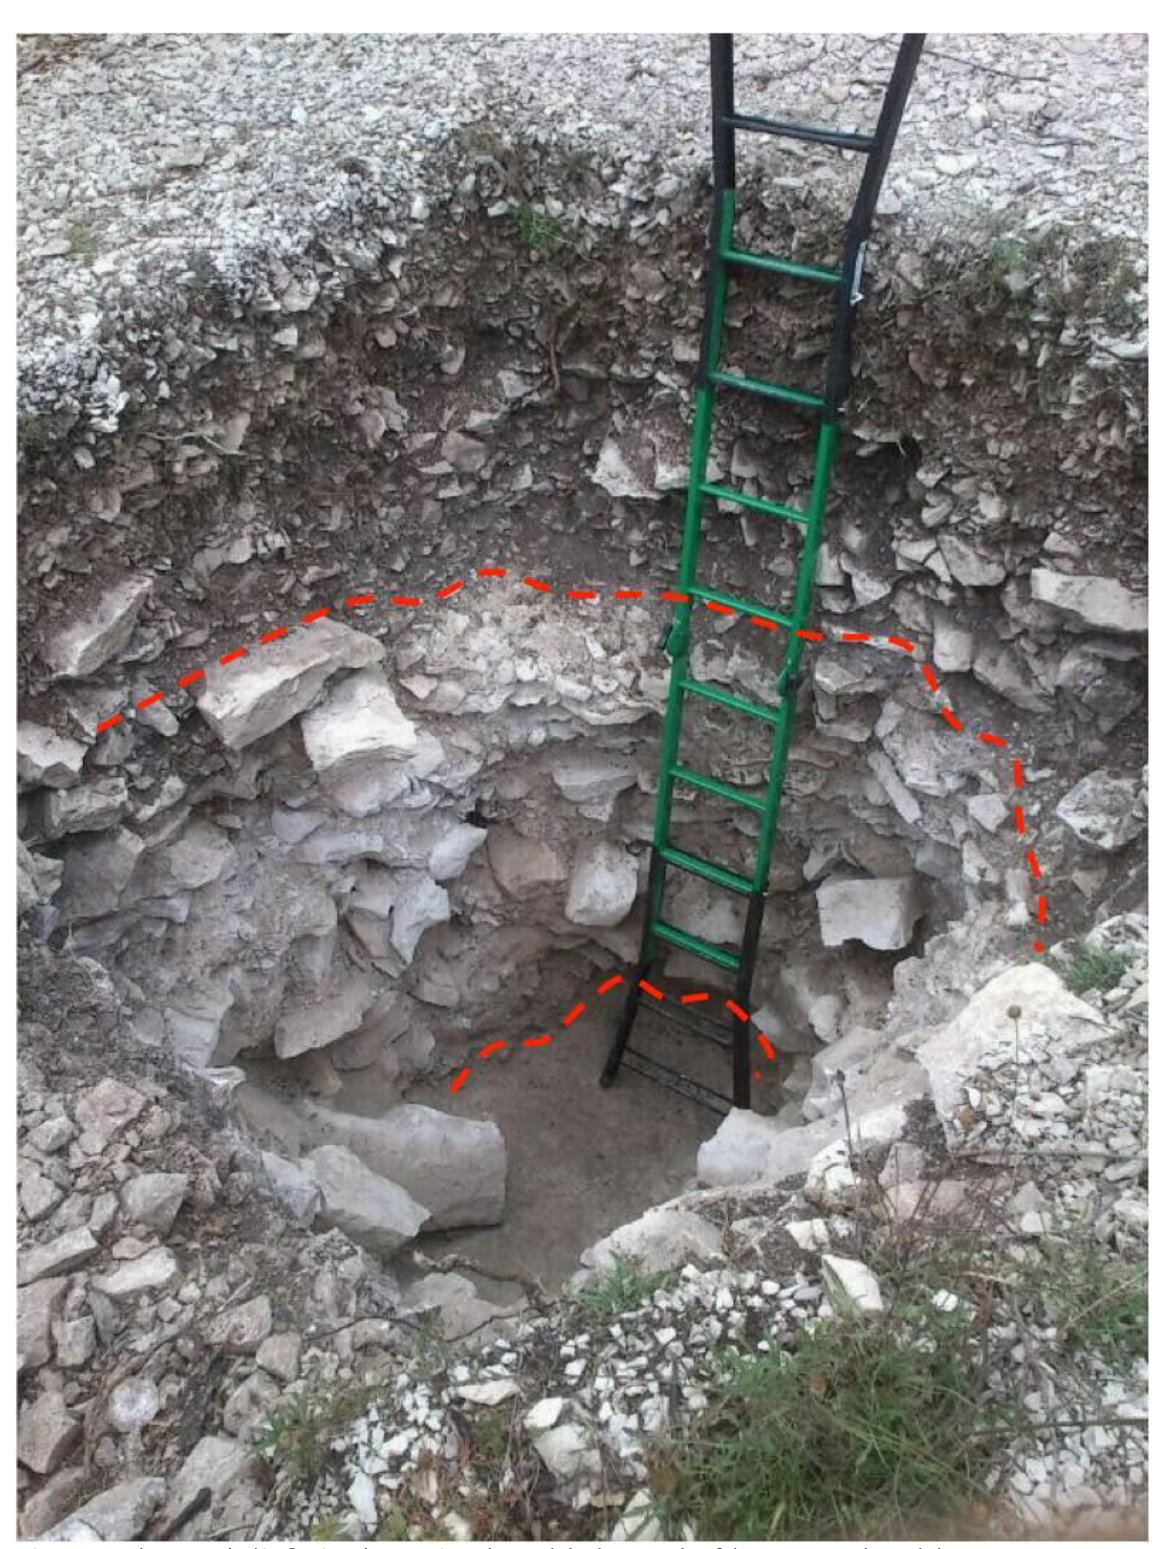
Figure 12. Photograph displaying the stratigraphy and the base rock of the crescent-shaped